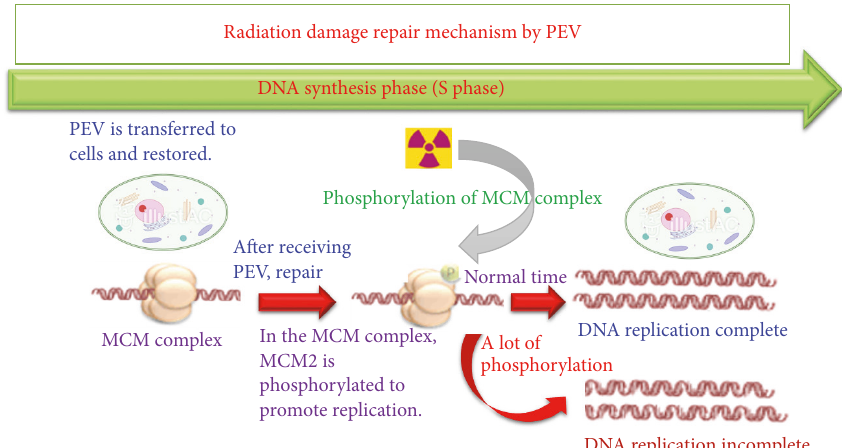
Figure 8: Identify normal DNA replication for radiation damage by PEV and allow progression to the next cleavage in called checkpoint mechanism. DNA that is incompletely replicated by radiation damage is recoverable by PEV and resumed cell division (MCM; mini chromosome